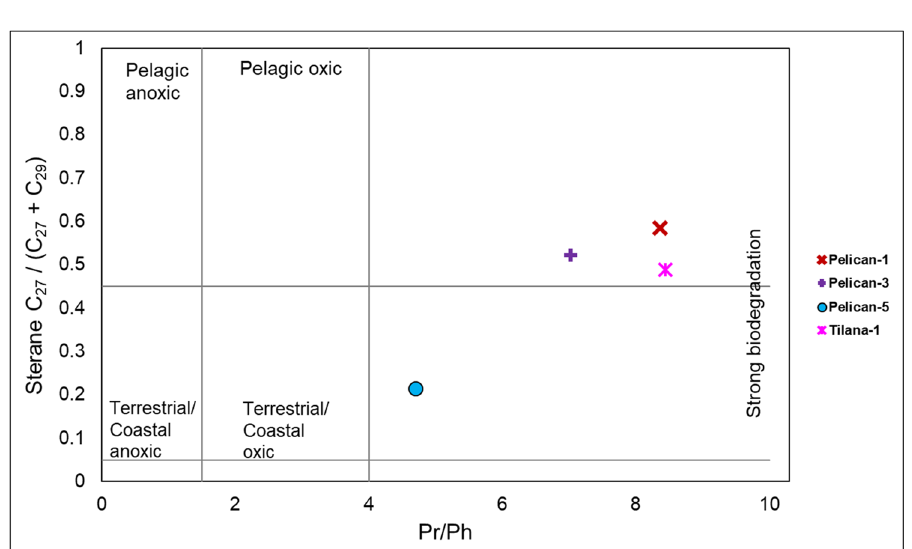
Fig. 16 Paleodepositional environment by plotting C 27 / (C 27 + C 29 ) sterane versus Pr/Ph (modified from Hossain et al.